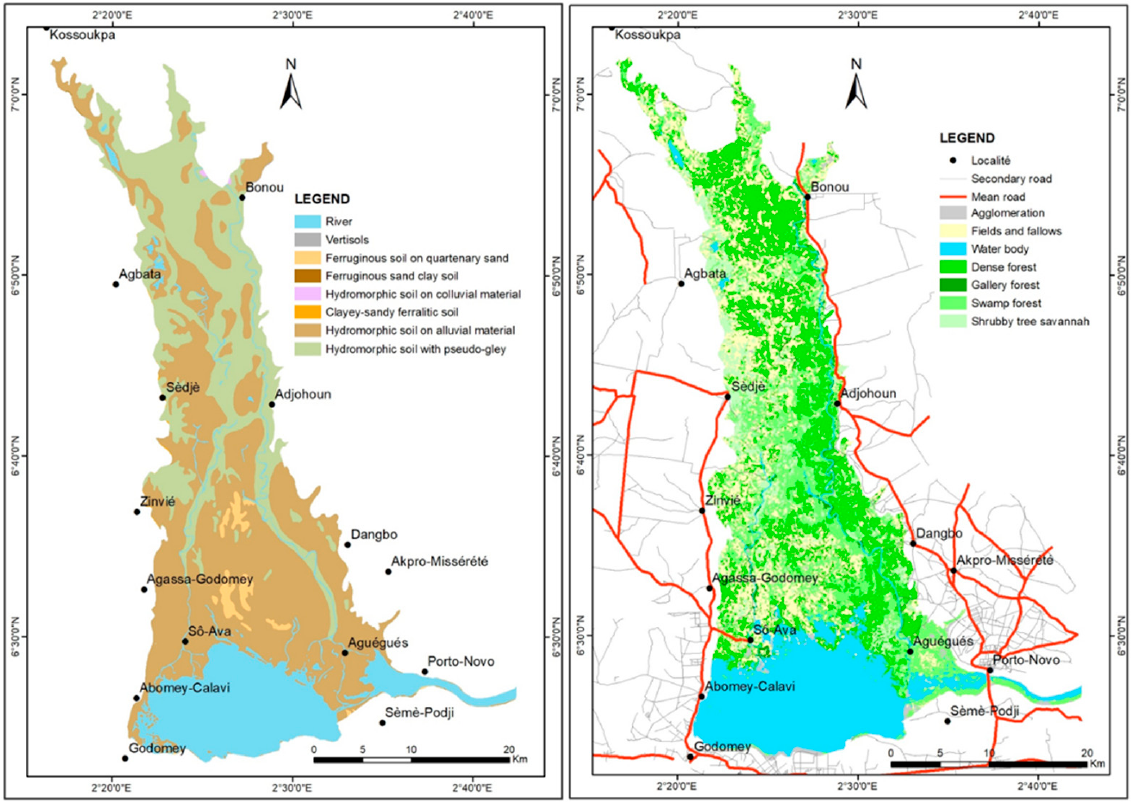
Figure 5. Maps of the spatial distribution of soil types 1976 ( left ) and road network 2018 ( right ) in the Ouémé Delta.